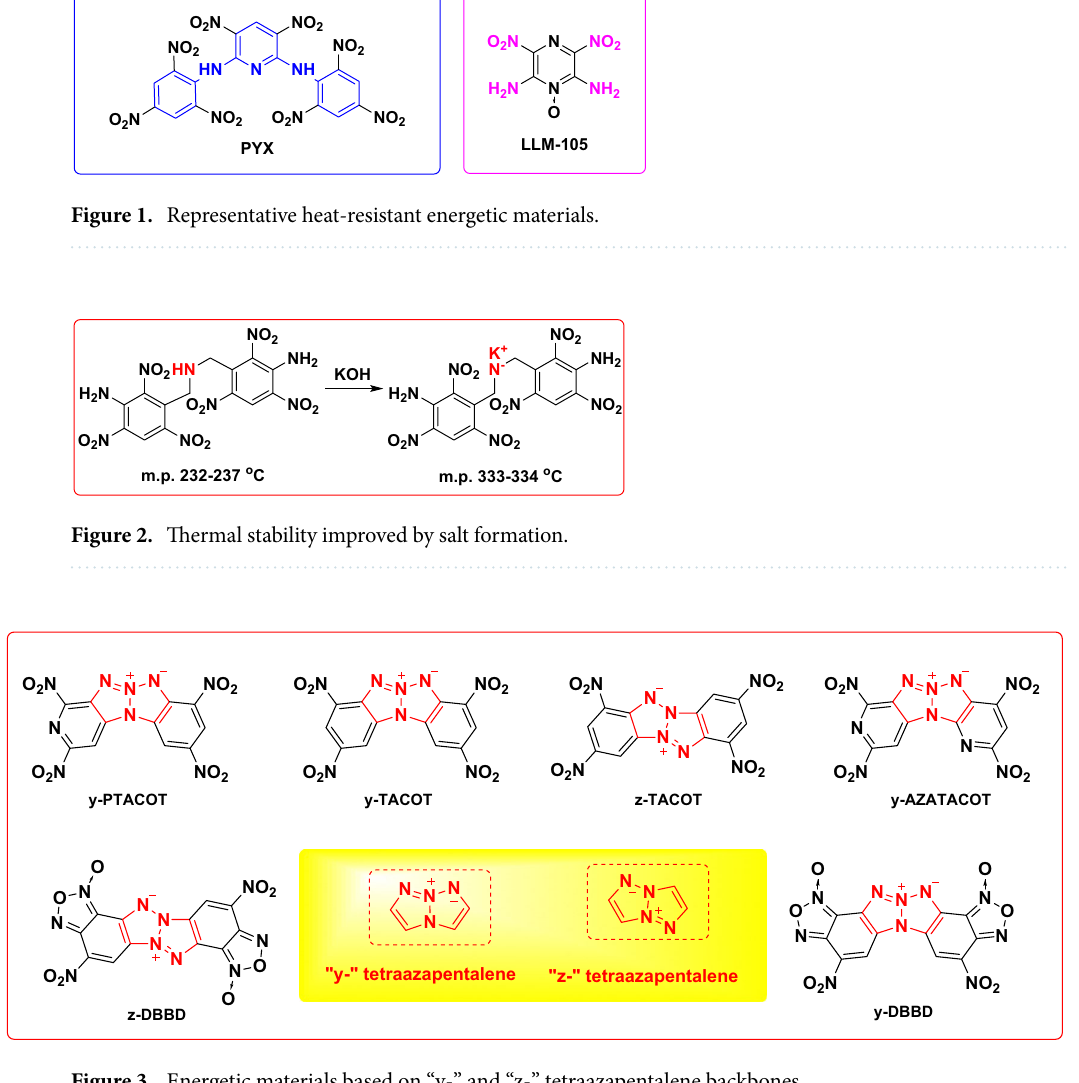
Figure 3. Energetic materials based on “y-” and “z-” tetraazapentalene